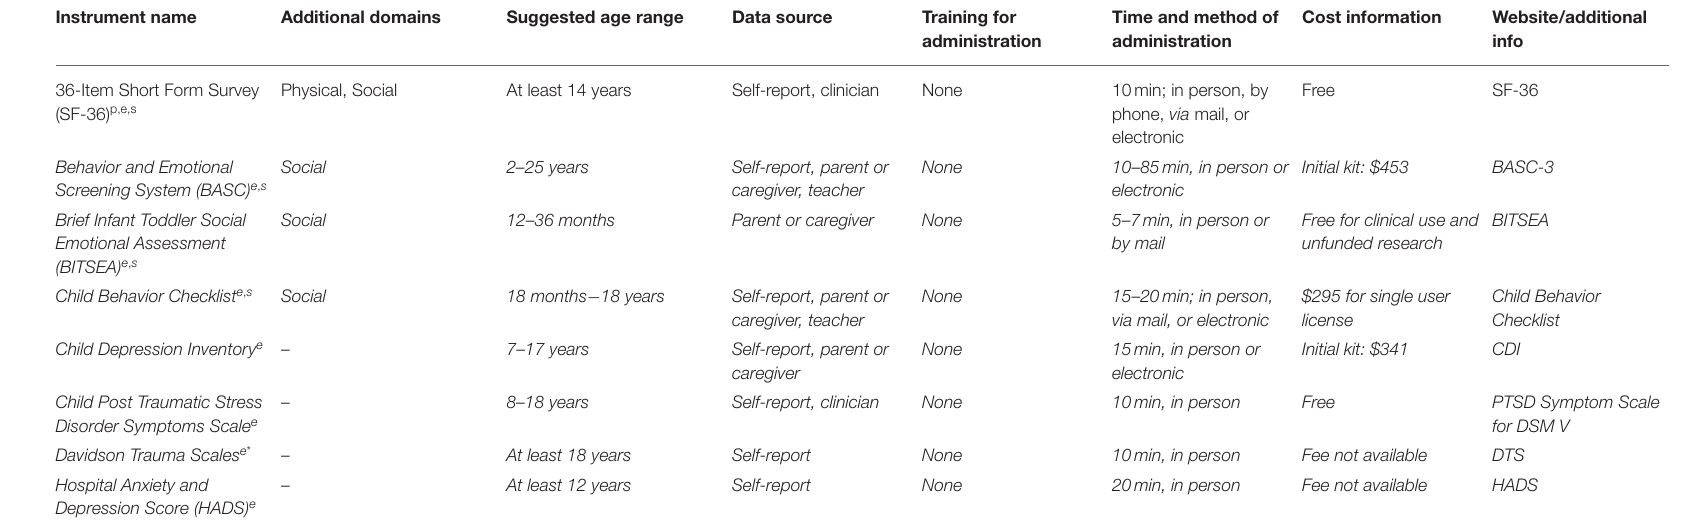
TABLE 8 | Mental health (e.g., anxiety, depression,